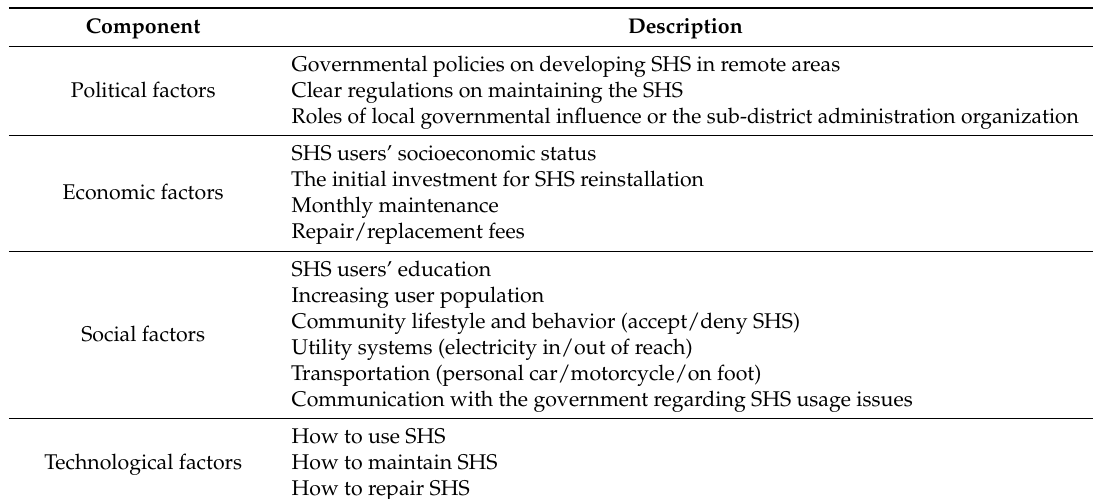
Table 1. Characteristics of external factors that affected the sustainable development of solar home system